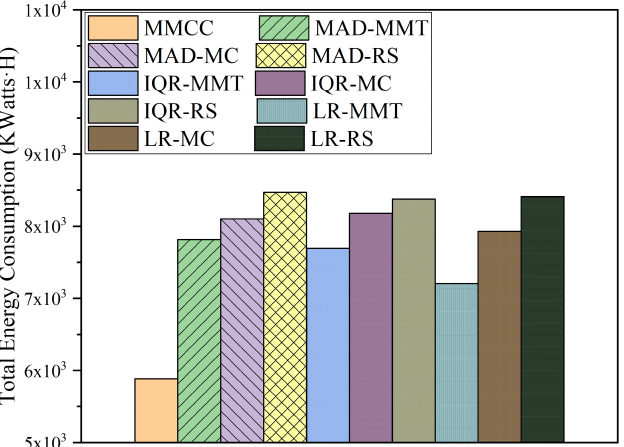
Figure 9. Comparing the total energy consumption hosts by all